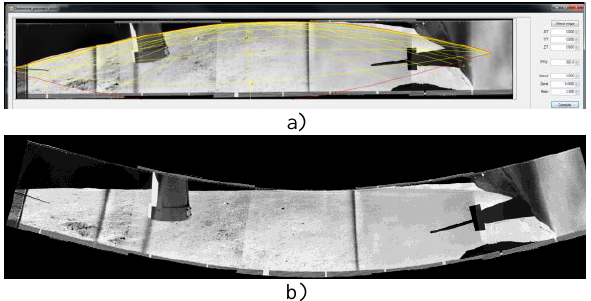
Figure 12. a) User interface of the PanoramaOrientation module; b) Lunokhod-2 archive panorama (# 6-405) corrected for the determined Lunokhod tilts (horizontal tilt – 2.3  , vertical tilt – 14.5 